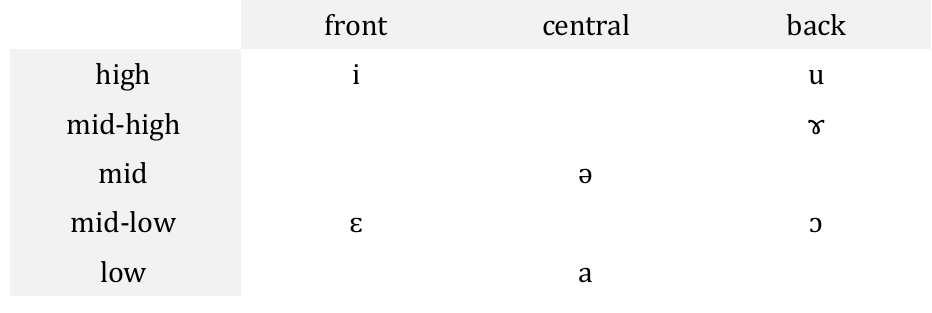
Table 1 : Ngwi vowel